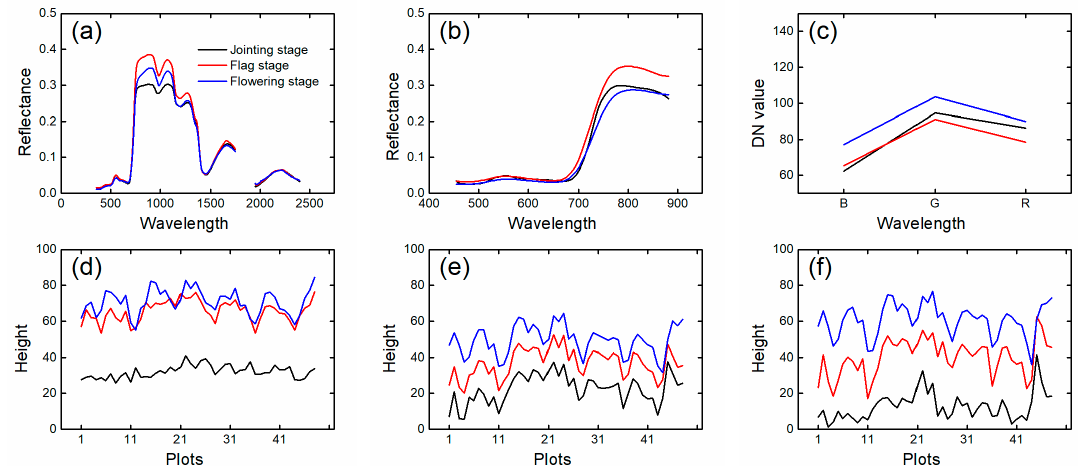
Figure 4. Averaged hyperspectral reflectance spectra, averaged DN values, and crop height in the three growing stages: ( a ) G-hyperspectral; ( b ) UHD-hyperspectral; ( c ) calibrated DC-DN values; ( d ) G-height; ( e ) UHD-height; ( f ) DC height. G- indicates data measured by ground-based ASD spectrometer and measuring stick; UHD- indicates data measured using the UHD 185 mounted on the UAV; and DC- indicates data measured by using the digital camera mounted on the UAV.